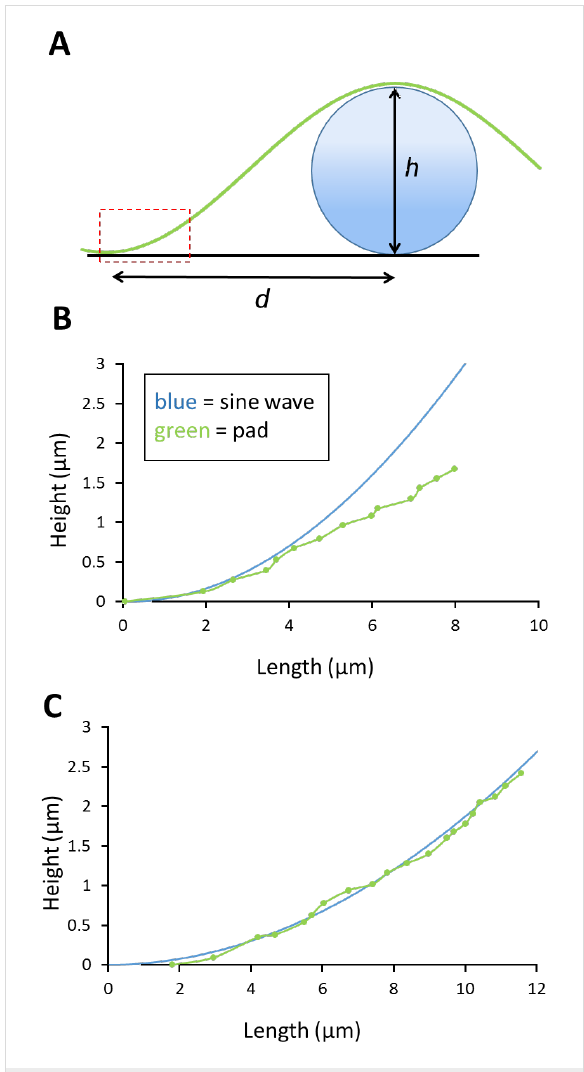
Figure 6: Modelling of the contact behaviour of the pad around a spherical asperity. A) Conceptual drawing showing the parameters used for the model. A sine wave with wavelength 2 d was used to fit a spherical bead with diameter h . The initial contact of the pad sepa- rating quickly from the surface can be seen using IRM (indicated by the dashed box). B) for smaller bead sizes (here h = 32.79 µm) the data points only follow the sine wave initially (before showing a slope underneath the sine wave curve, indicating a soft material) whereas the fit is better for larger particle in example C ( h = 57.92